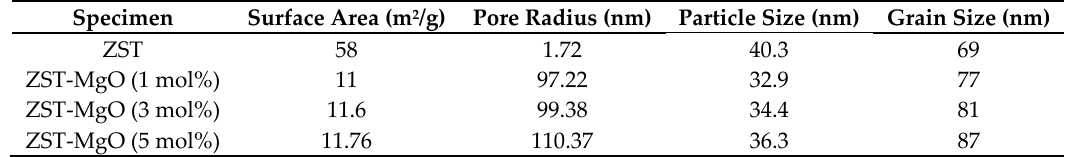
Table 1. Surface area, pore radius, average particle size and grain size of the nanocomposites and thick film sensors as function of the doping value.